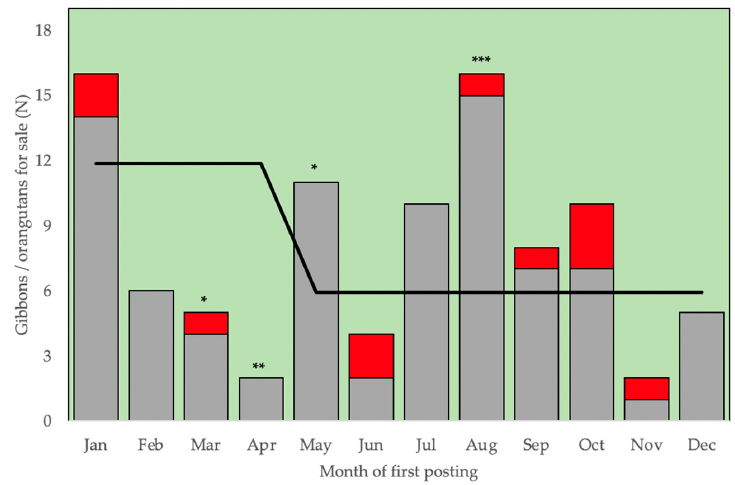
Figure 2. Temporal pattern of gibbons (gray bars) and orangutans (red bars) for sale on Facebook and Instagram in Indonesia in January 2017–April 2018 and January 2020–April 2021. Values are added together by month. The line is the expected number based on monthly survey efforts. Asterisks indicate levels of significance based on χ 2 tests: *- p <0.05; **- p <0.01; ***- p <0.001.